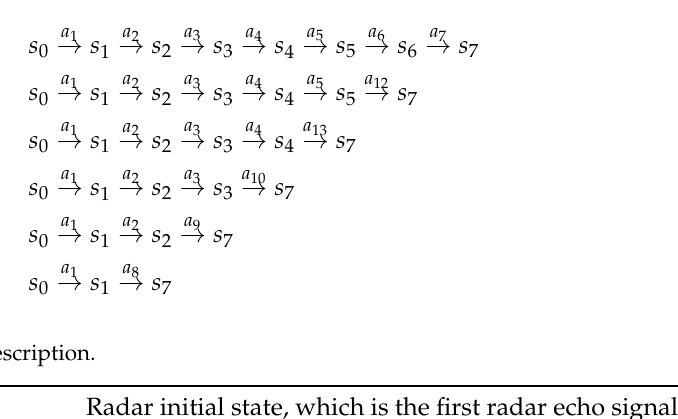
Figure 7. Radar system state-action transition diagram.